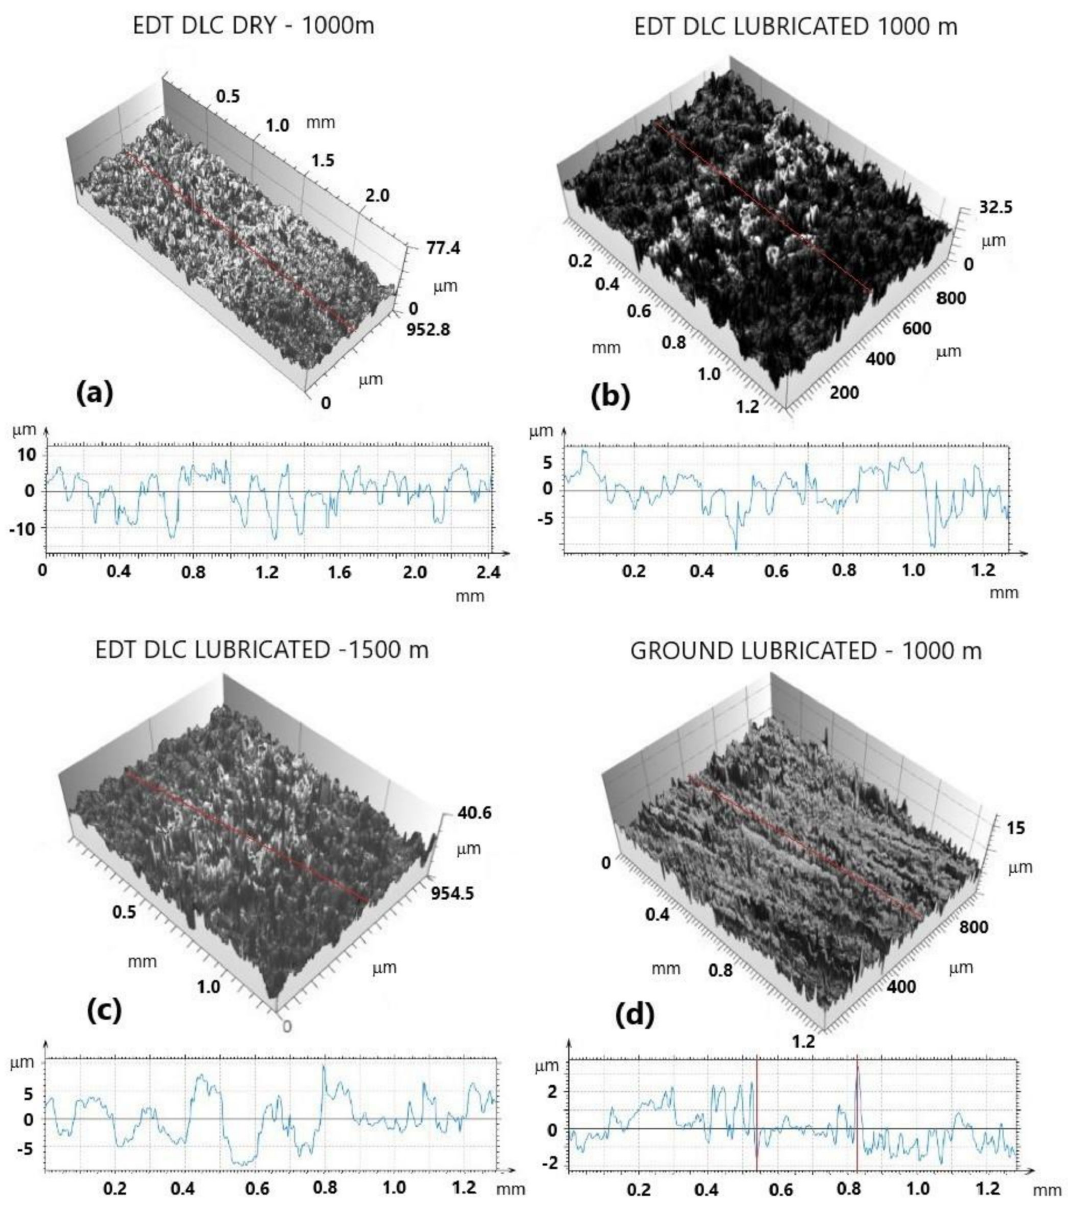
Figure 13. Optical interferometry of the worn tracks (3D maps and selected 2 D profiles: ( a ) EDT DLC dry, 1000 m sliding; ( b ) EDT DLC lubricated, 1000 m sliding; ( c ) EDT DLC lubricated, 1500 m sliding; and ( d ) ground lubricated, 1000 m